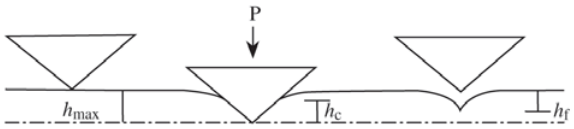
Figure 1. Profile of the surface before and after indentation.